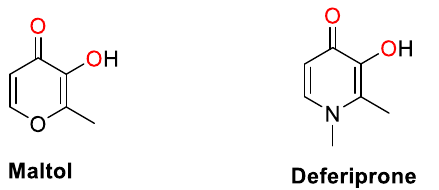
Figure 1. Chemical structures of maltol and deferiprone as representative examples of hydroxy- pyr(id)ones, and their chelating atoms highlighted in red.